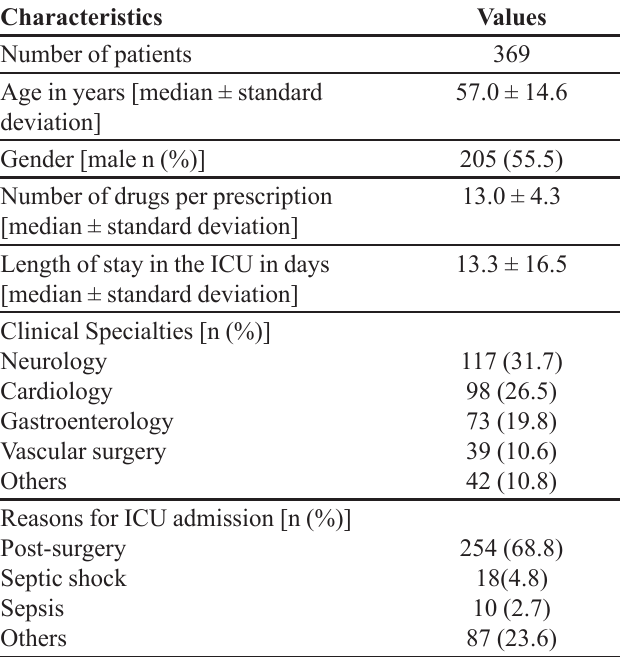
TABLE I - Patient clinical and demographic characteristics